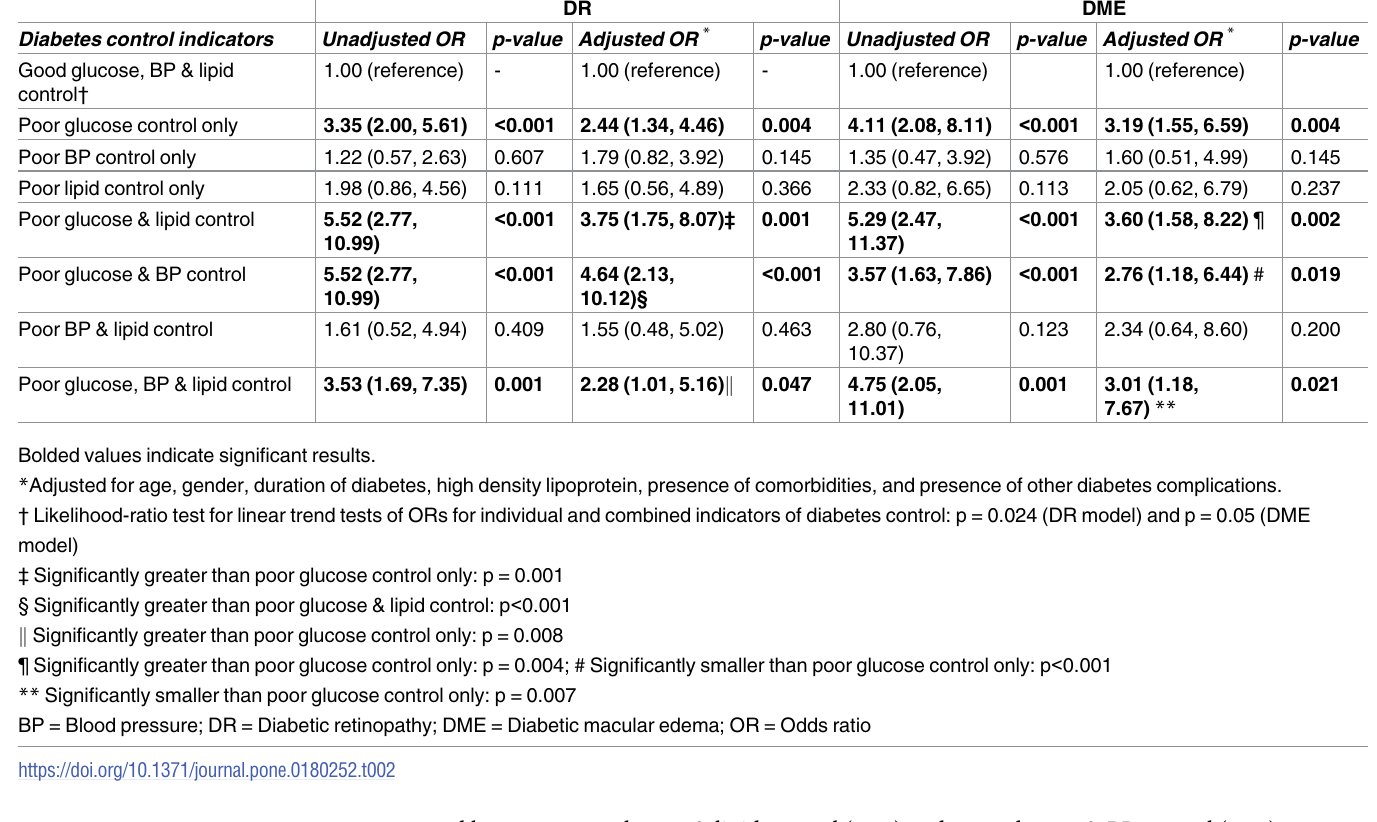
and between poor glucose & lipid control (3.75) and poor glucose & BP control (4.64) were p = 0.001 and p < 0.001, respectively. A very similar pattern was observed when we adjusted for medication use in the sub-sample of participants with medication data ( S3 Table ). Overall,